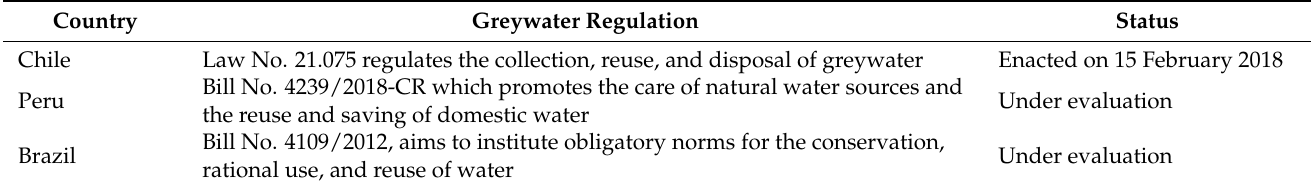
Table 3. Countries in Latin America and the Caribbean that have or are processing legislation on the reuse of